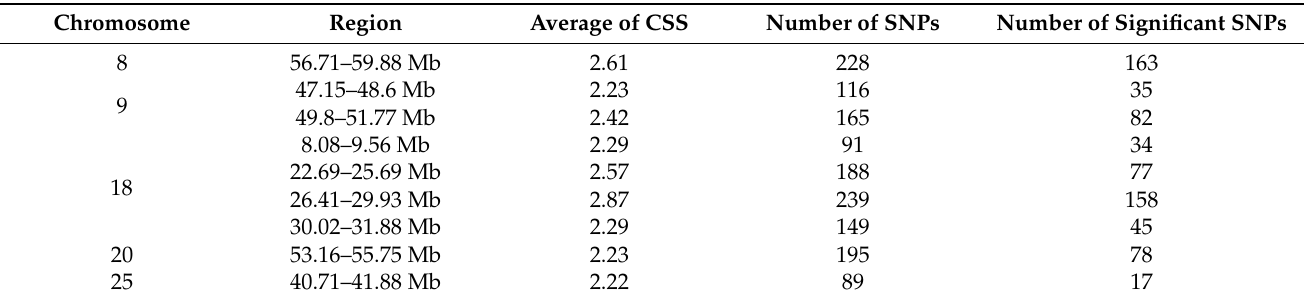
Table 3. Summary of significant regions identified in the comparison of Bullmastiff and other breeds within the European Mastiff